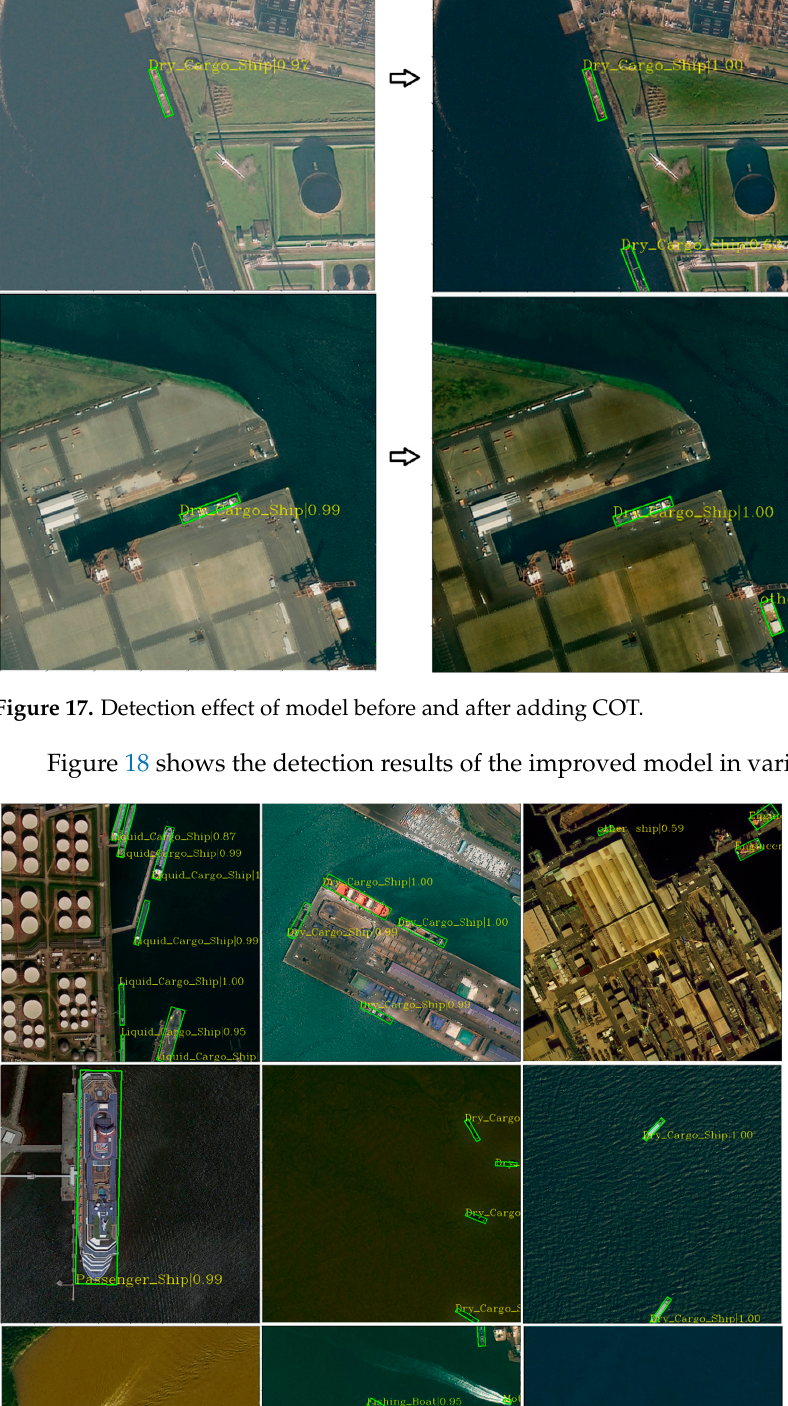
Table 6. AP values of various targets detected using different deformation convolution sizes.